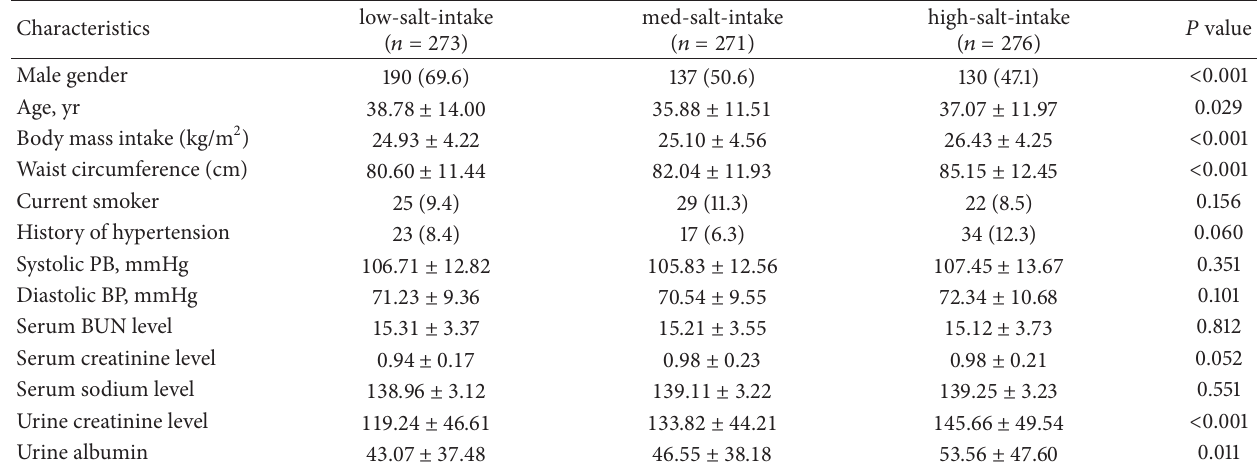
Table 1: Baseline characteristics and clinical data of study